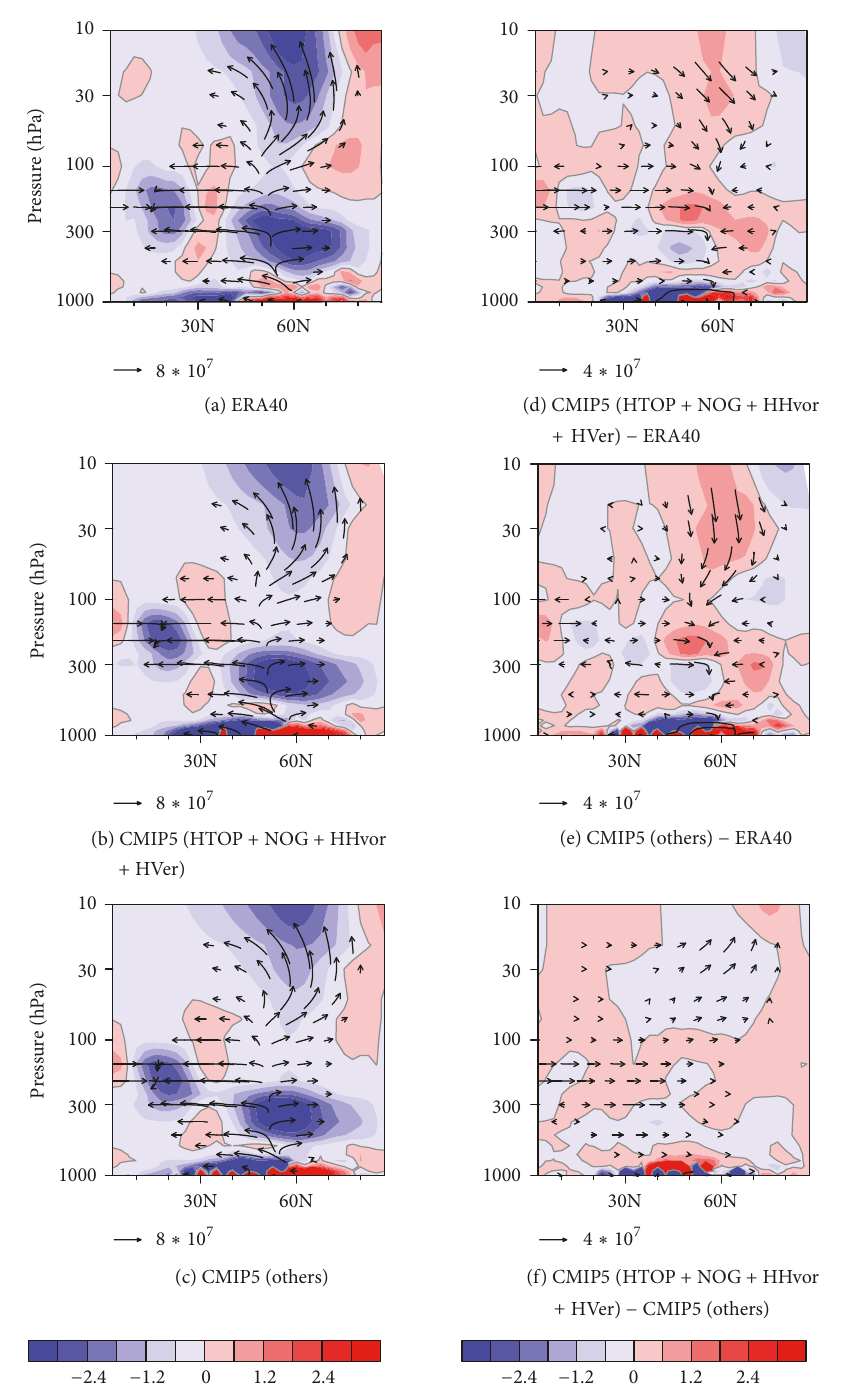
Figure 7: The EP flux cross section of planetary waves (vectors) and its divergence (contours) for (a) ERA40, (b) CMIP5 7ME (ensemble of the 7 models with HTOP, NOG, HVer, and HHor), (c) CMIP5 OME (ensemble of the other models except the above models), (d) the difference between CMIP5 7ME and ERA40, (e) the difference between CMIP5 OME and ERA40, and (f) the difference between CMIP5 7ME and CMIP5 OME. The 𝑝 fluxes are scaled by the inverse of the air density and the units are kg s −2 . The EP flux divergence contour interval is 0.6 m s −1 day −1